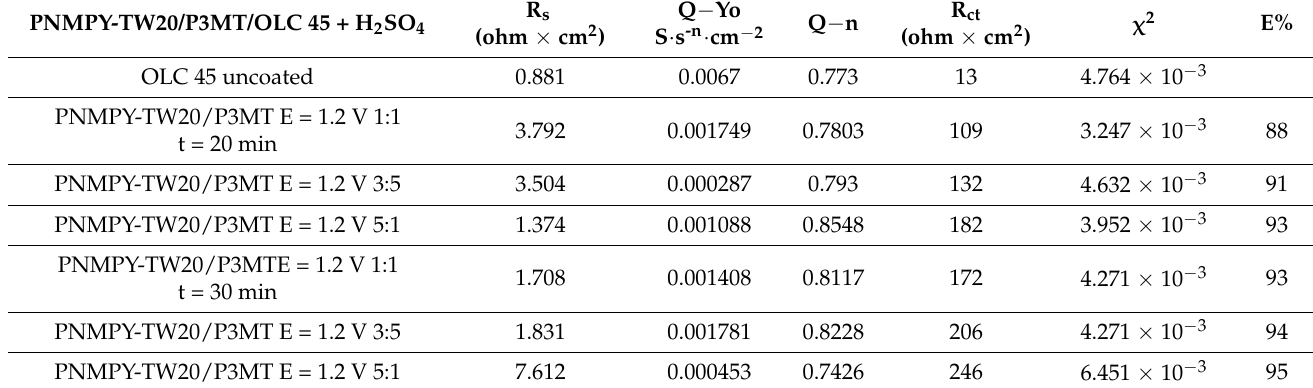
Table 8. EIS parameters of uncoated and coated by PNMPY-TW20/P3MTof OLC 45 sample in 0.5M H 2 SO 4 medium at 25 ◦ C.